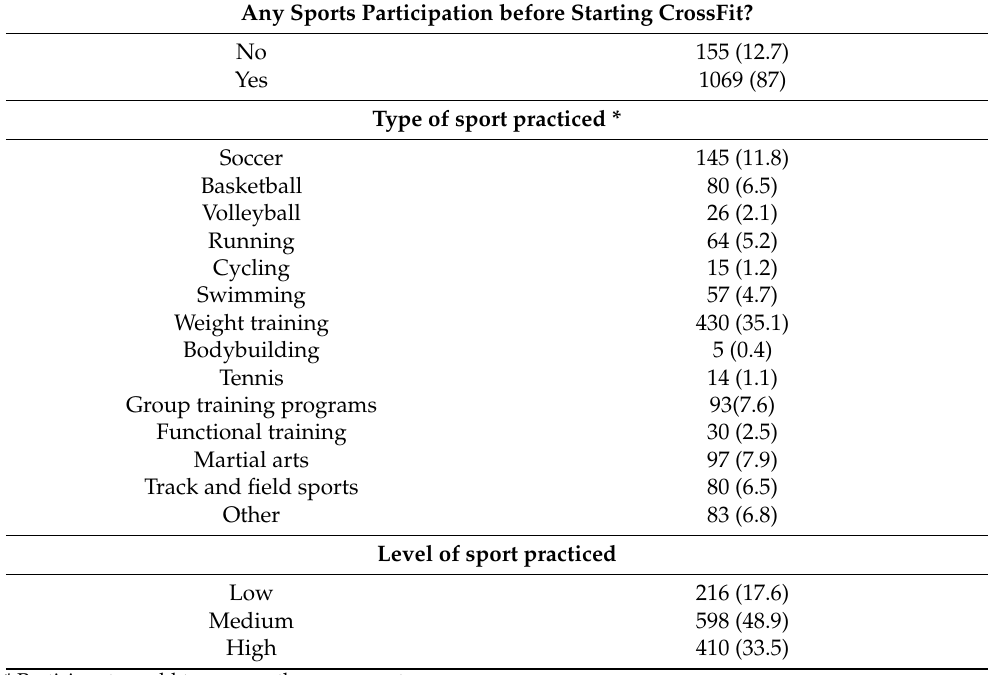
Table 2. Sports Training History Prior to Practicing CrossFit.